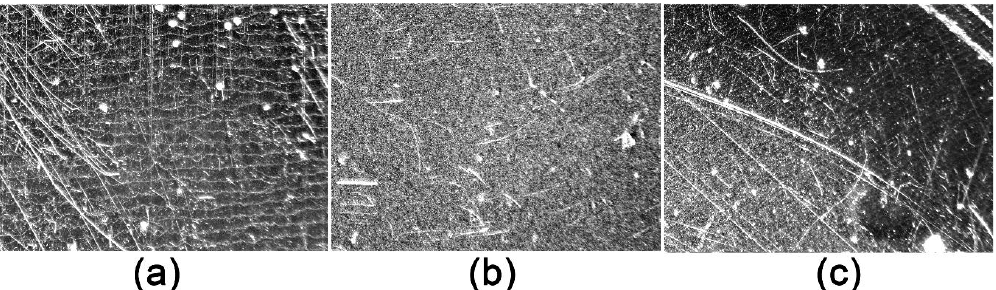
Figure 6. Surface texture of ( a ) unstressed and ( b ) stressed low density polyethylene (LDPE) carbon black (CB)-nanocomposites. ( c ) shows the transition region between abraded (lower left region) and unstressed (upper right region) polymer surface at which the cell closure was placed (images taken at hundredfold magnification with an optical light microscope).